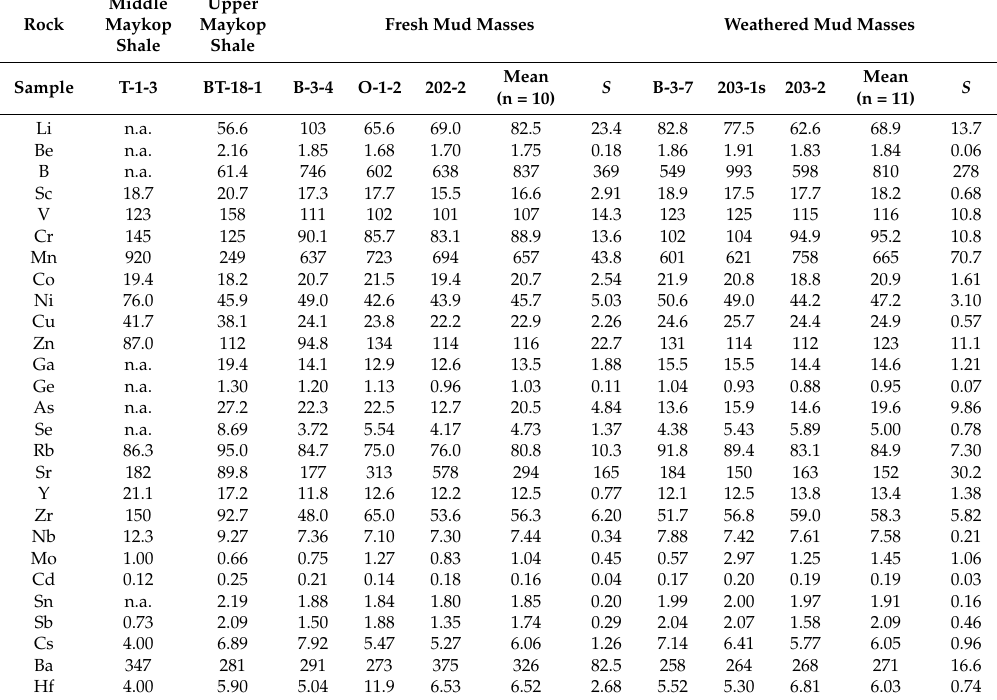
Table 2. Trace and rare earth element composition (in ppml) of representative mud masses from the Bulganak mud volcano area in comparison with Middle and Upper Maykop shales (Kerch-Taman MV